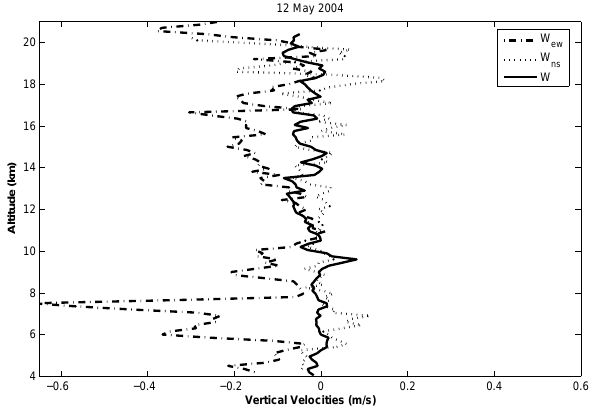
Fig. 8. Same as Fig. 6, but for a different day (12 May